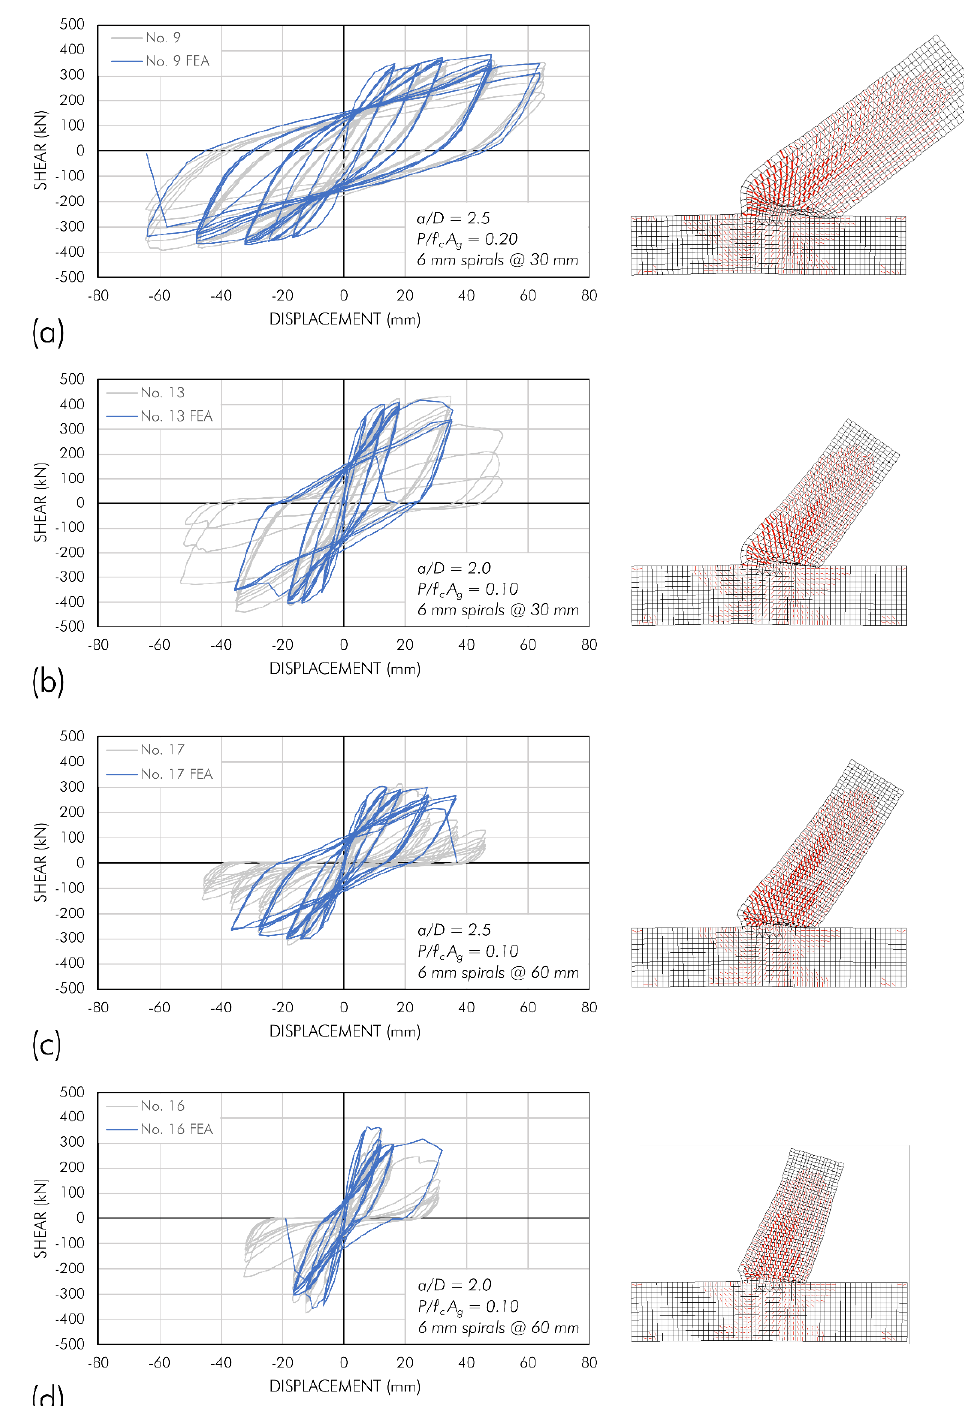
Figure 7. Nonlinear finite element analysis predictions of shear-deflection responses and deflected shapes at failure (20× magnification) for columns tested by Ang et al. [6,7]: ( a ) No. 9 (ductile flexure failure); ( b ) No. 13 (shear failure with moderate ductility); ( c ) No. 17 (shear failure with limited ductility); ( d ) No. 16 (brittle shear